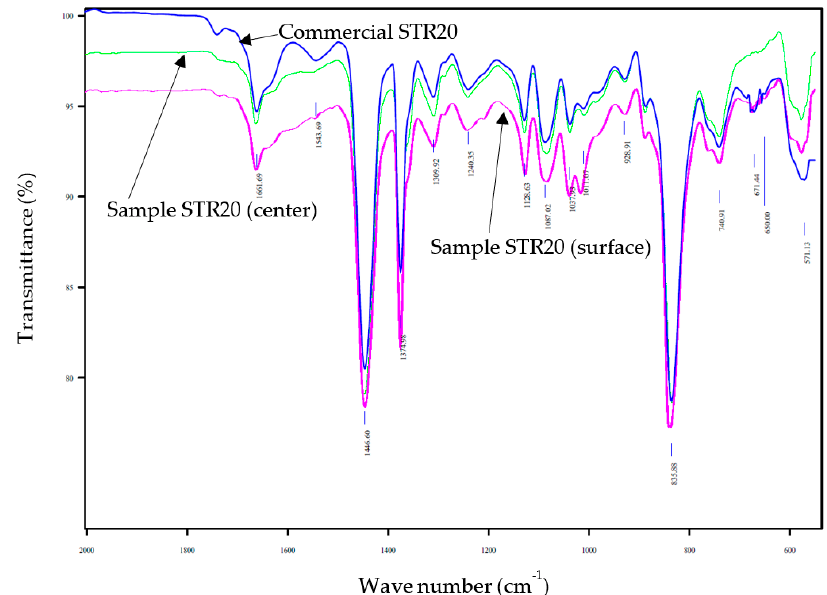
Figure 11. Examination of the chemical structure for STR 20 using the attenuated total reflection Fourier transform infrared spectroscopy (ATR-FTIR) technique compared to commercial hot air dried rubber.